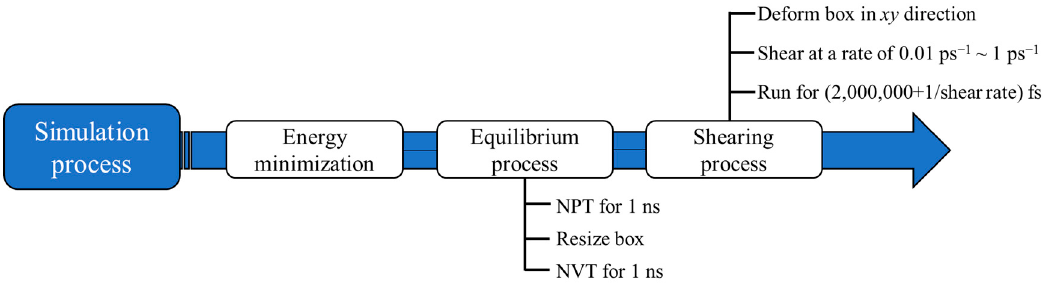
Figure 3. Simulation steps.